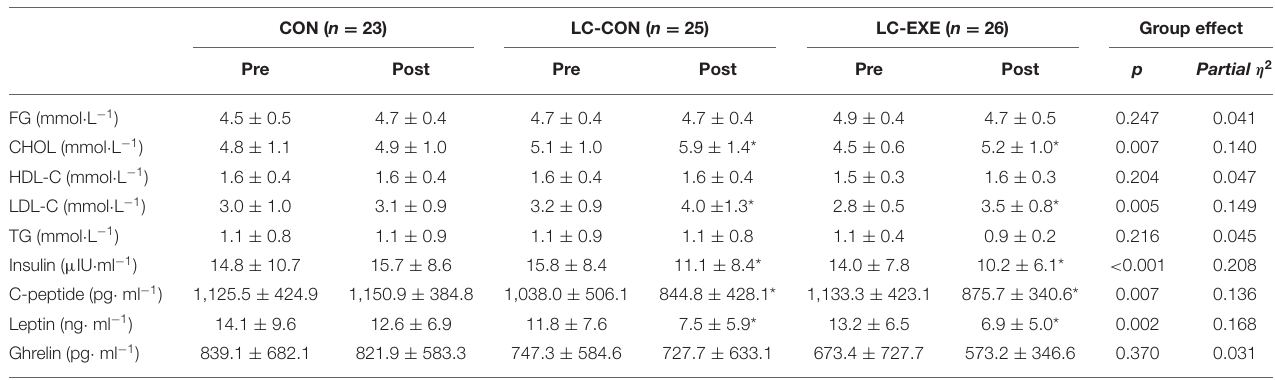
TABLE 3 | Blood parameter outcomes before and after 4 weeks of